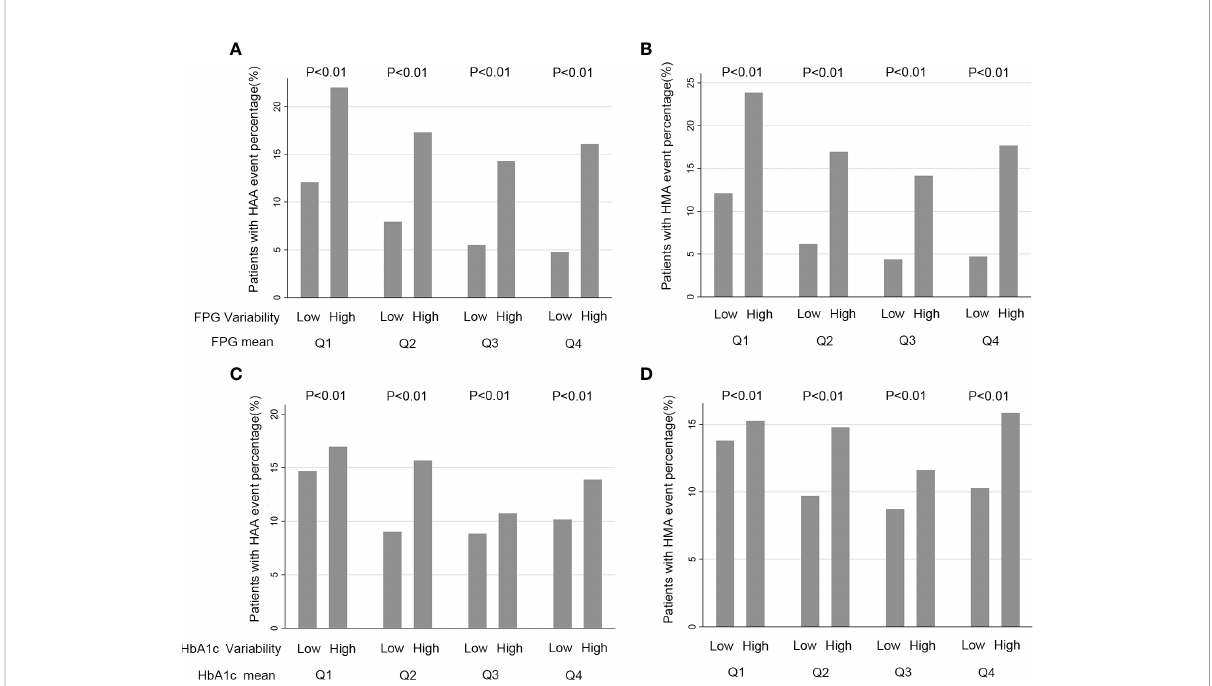
FIGURE 1 Quartiles of HbA1c/FPG variability and rate HAA/HMA Events a Function of Baseline HbA1c/FPG. (A, B) FPG (Fasting Plasma Glucose) and FPG variability, Q1 is de fi ned as a FPG mean located in fi rst quartile, Q2 located a FPG mean in second quartile, Q3 a FPG mean located in third quartile and Q4 a FPG mean located in a fourth quartile; (C, D) HbA1c (hemoglobin A1c) and HbA1c variability. Q1 is de fi ned as a HbA1c mean located in fi rst quartile, Q2 a HbA1c mean located in second quartile, Q3 a HbA1c mean located in third quartile and Q4 a HbA1c mean located in fourth